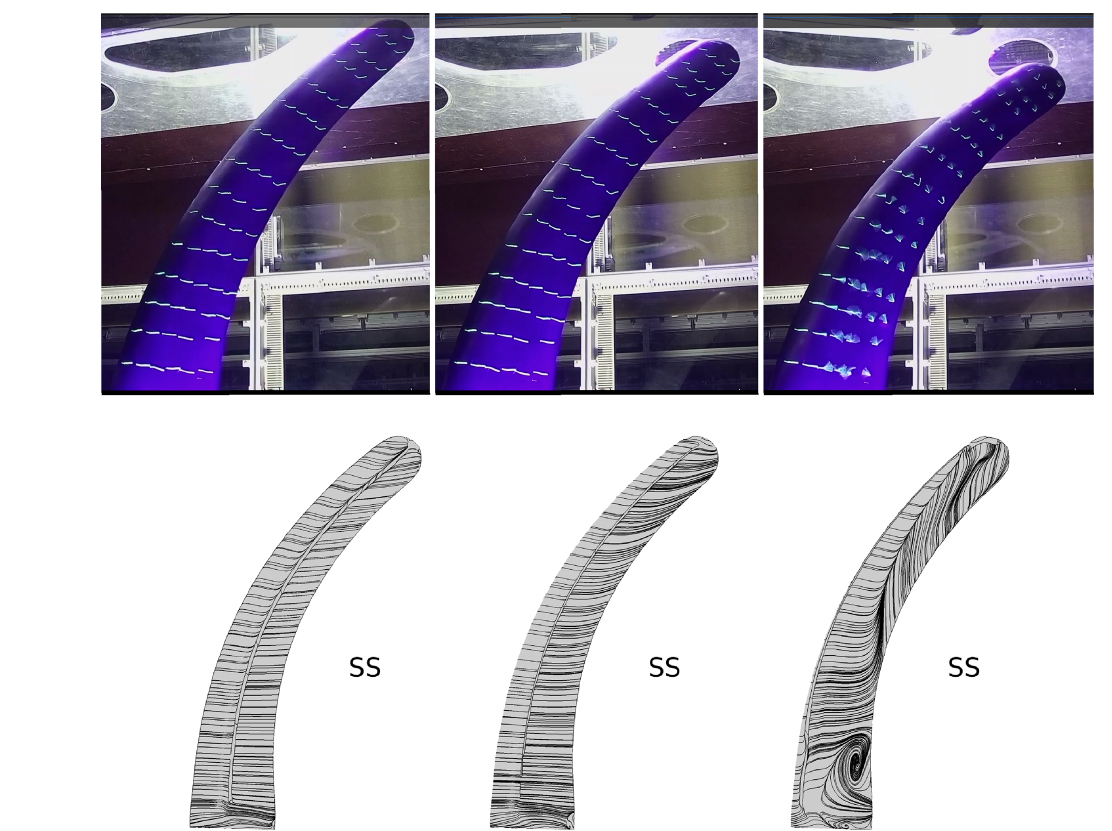
Figure 12. Surface flow visualization. Left column: 0 ◦ AOA. Middle column: 10 ◦ AOA. Right column: 20 ◦ AOA. Upper row: experimental results. Lower row: